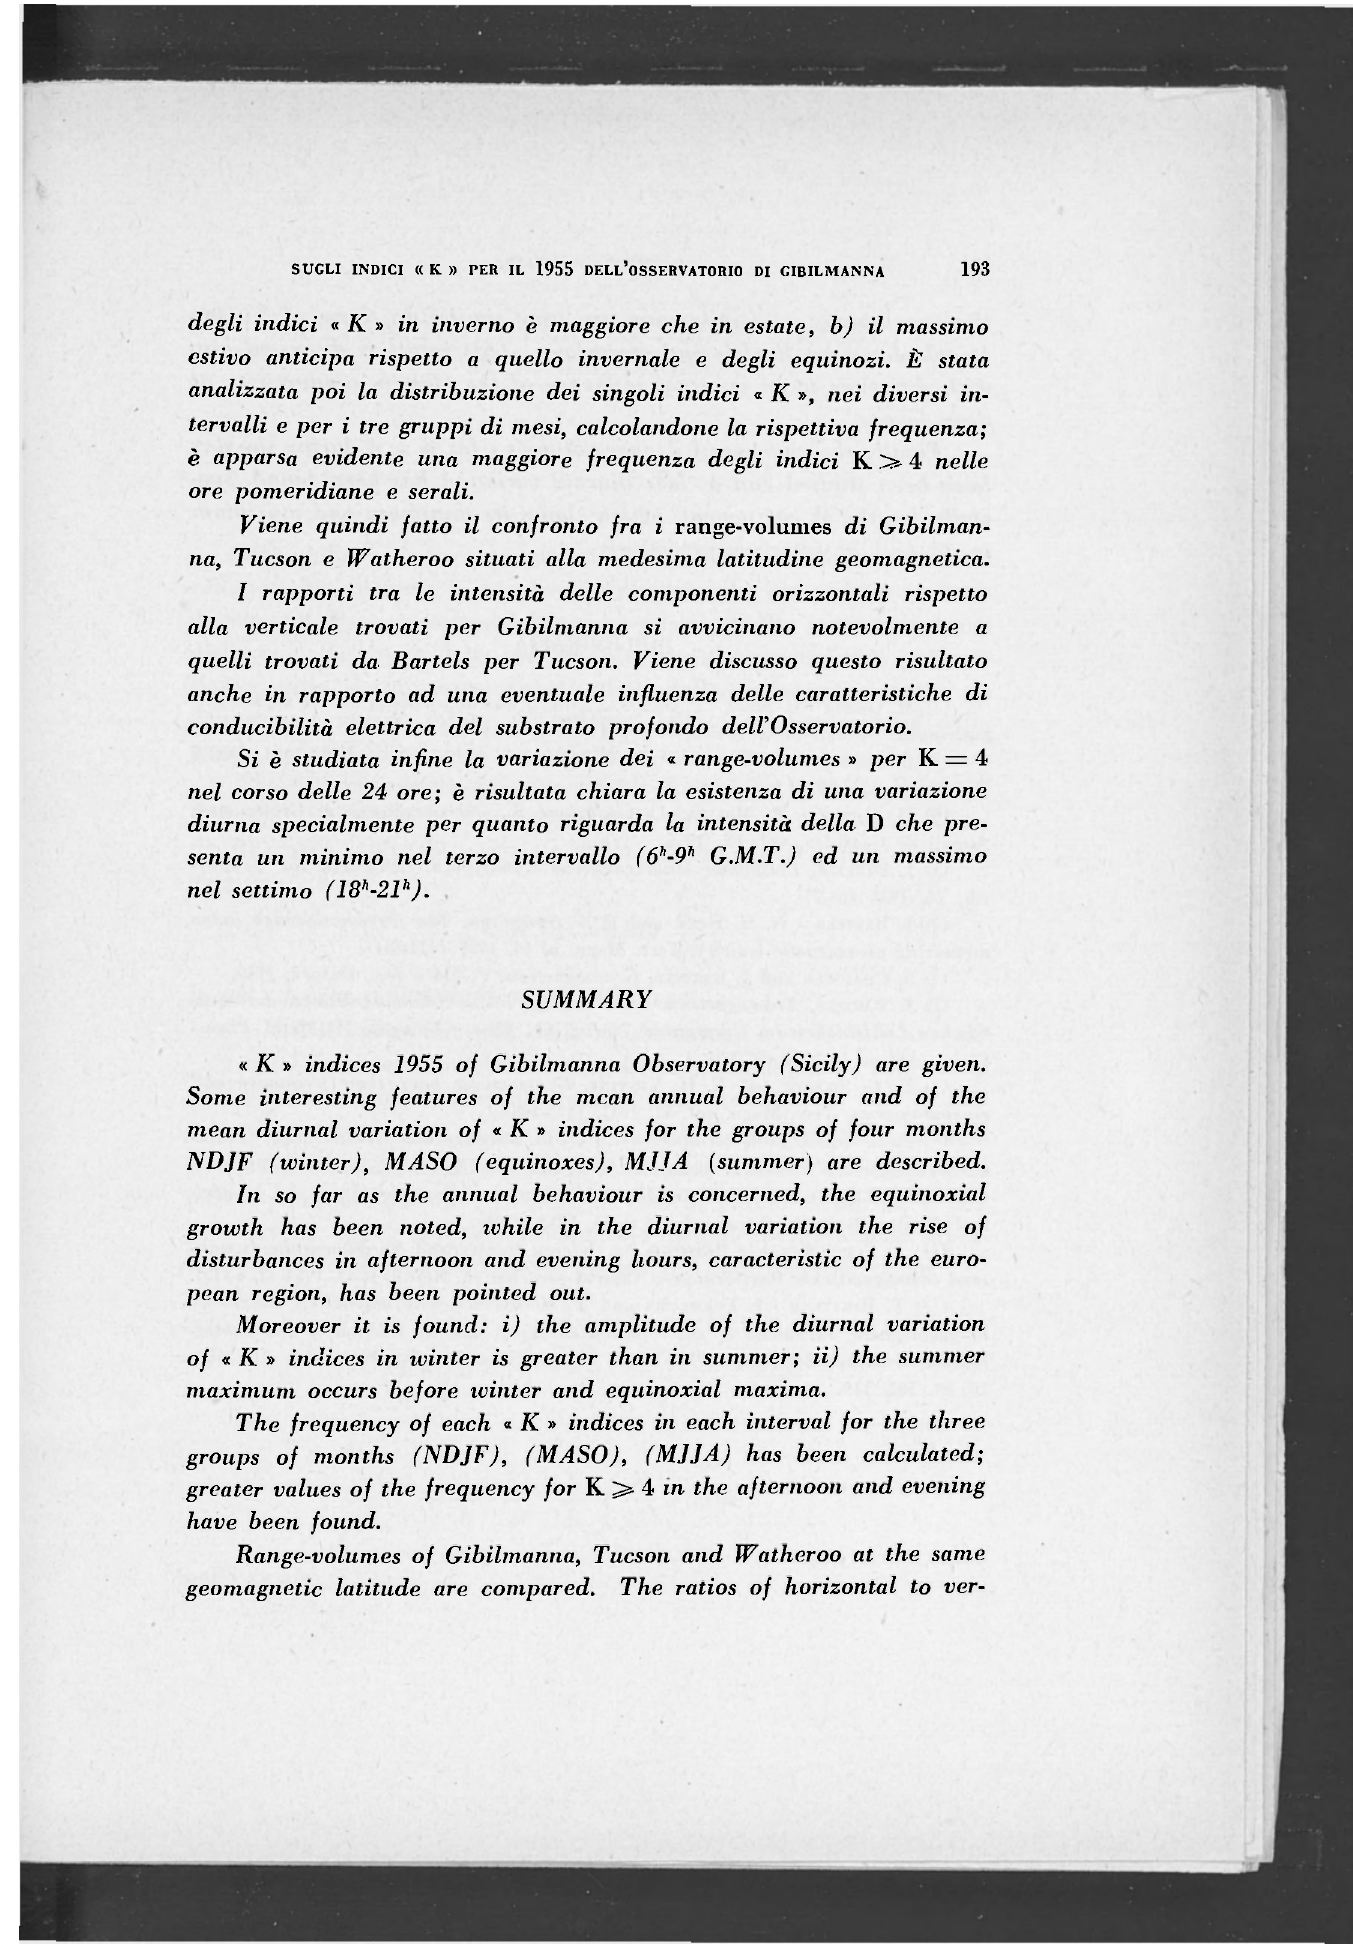
(MASO), (MJJA) has been calculated; greater values of the frequency for K > 4 M the afternoon and evening have been found. Range-volumes of Gibilmanna, Tucson and Watheroo at the same geomagnetic latitude are compared. The ratios of horizontal to